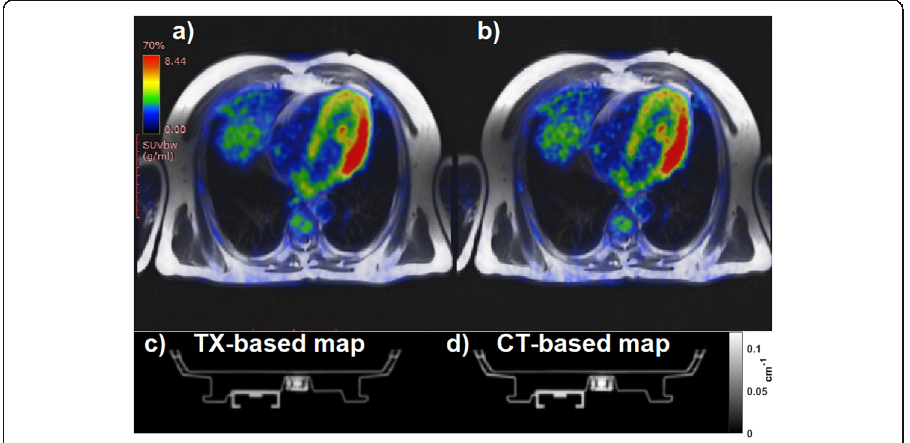
Fig. 5 Fused images ( a and b top) of the 2D-HASTE MRI to 18F-FDG PET for a volunteer. a The offline reconstructed PET with the scanner using hardware TX-based maps (both, patient table and posterior part of the array). b The same PET data, reconstructed using hardware CT-based maps. The lower row of